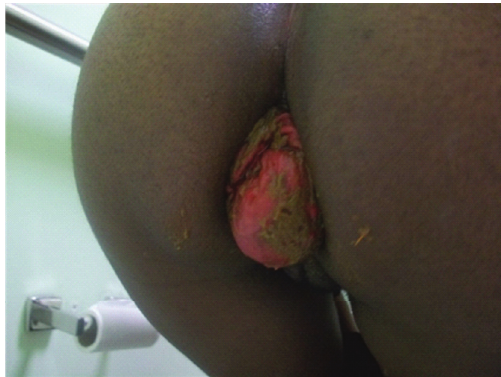
Figure 1: Prolapse of ileoanal J-pouch with straining, at initial visit. (normal range: 40–80 mm Hg) and 45–65 mm Hg (normal range: 80–160 mm Hg), respectively.